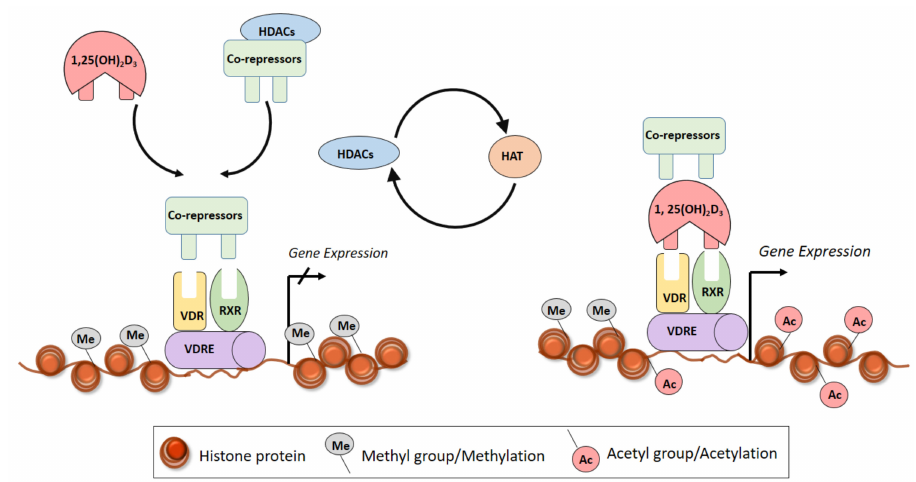
Figure 4. Schematic illustration of histone modification mechanisms mediated by vitamin D3 and the link to basal transcription machinery. The DNA is packaged within the eukaryotic cell leading to a compact higher order stature forming the dense arrays of nucleosomes seen in heterochromatin regions. Since the chromatin is tightly packed, the chromatin is in-accessible to transcription factors. The direct protein-protein interaction with co-activators which have HAT activity leads to local chromatin opening. Two major epigenetic mechanisms facilitates relaxation of chromatin structure and promotes gene expression; mainly DNA methylation and Histone protein modifications. ( a ) DNA methylation in the promoter region of VDR gene results in the inactivation and lack of VDR gene expression. ( b ) When HDAC-corepressor complexes are bound to the heterochromatin region, the transcriptional machinery is repressed resulting in downstream gene silencing. ( c ) When VDR-RXR complex is bound to HATs, HAT transfers acetyl group to histones leading to histone acetylation and chromatin remodelling. The chromatin machinery is then relaxed resulting in binding of TFs and activation of expression of downstream genes. Abbreviations: HAT, Histone Acetyl Transferase; HDAC, Histone deacetylase; RXR, Retinoid X Receptor; VDR, Vitamin D Receptor; VDRE, Vitamin D Response